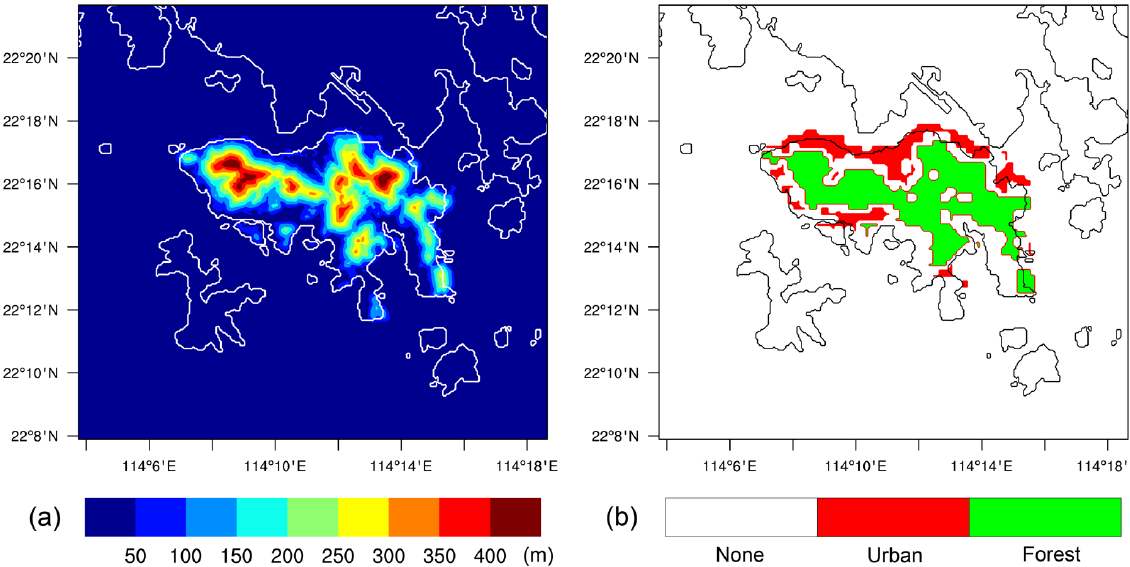
Figure 2. Elevation of the topography for Hong Kong Island (a) and emission map ( b ); red is the anthropogenic emission area, and green represents the biogenic